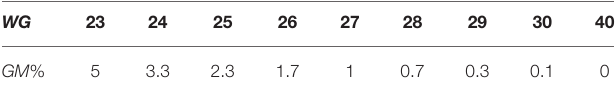
TABLE 4 | Volume fraction of germinal matrix (in% from total brain volume)